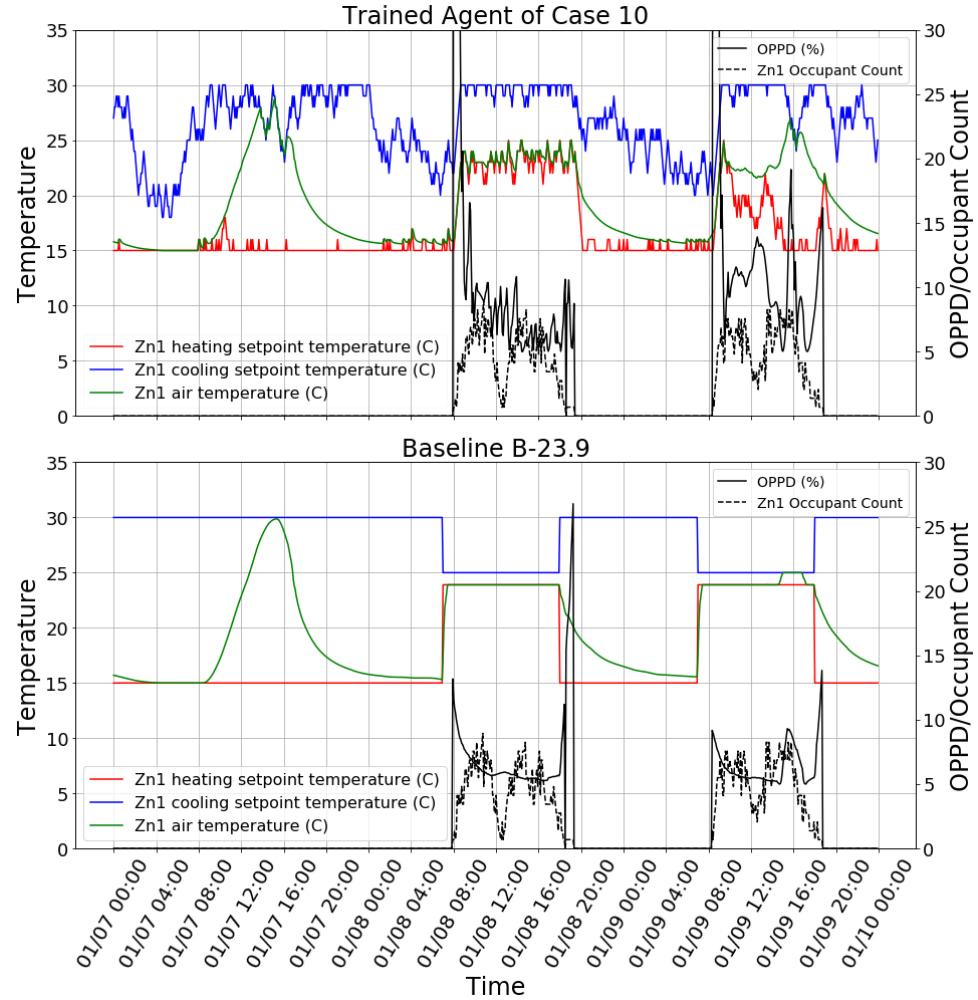
Figure 8. Multizone testing in the testing building model: control behavior snapshot of the trained agent of case 10 ( top ) and the baseline case B-23.9 ( below ).